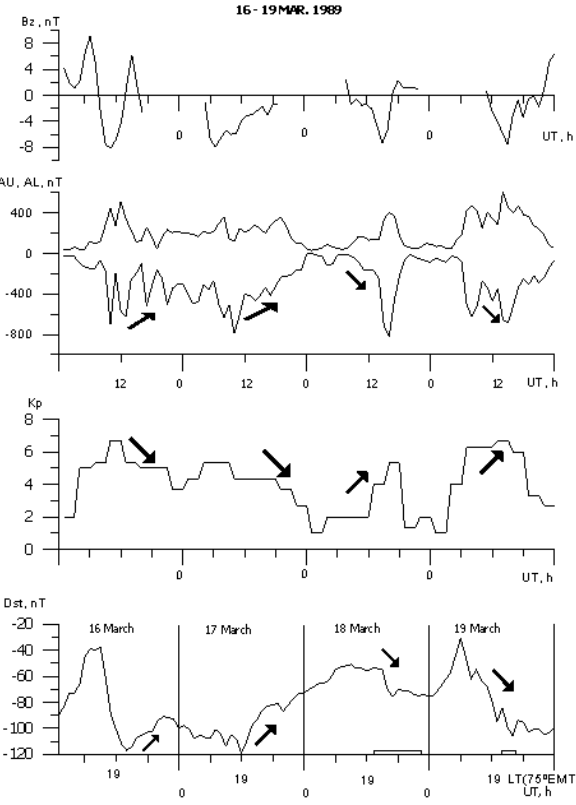
Fig. 5. Storm 5: 16–19 March 1989, (Category 3). The upper two panels show the IMF B z , AU and AL variations. The lower two panels show the K p and D st indices. The scintillation durations in the Indian sector are shown by the rectangles along the time axis of the D st